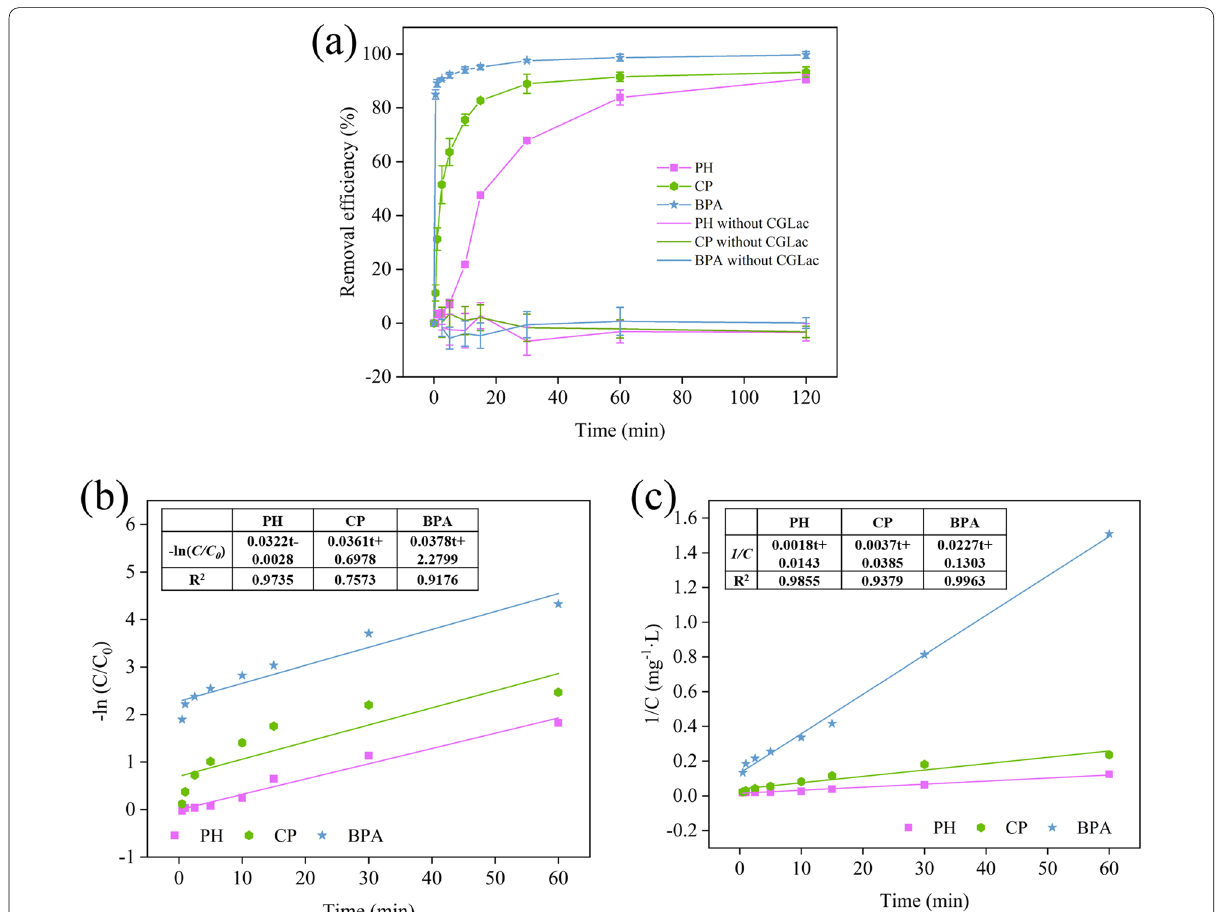
Fig. 8 a Removalefficiency of phenol (PH), 4-chlorophenol (CP), and bisphenol A (BPA) by CGLac. The first-order kinetic model( b ) and second-order kinetic model ( c ) of PPs removal